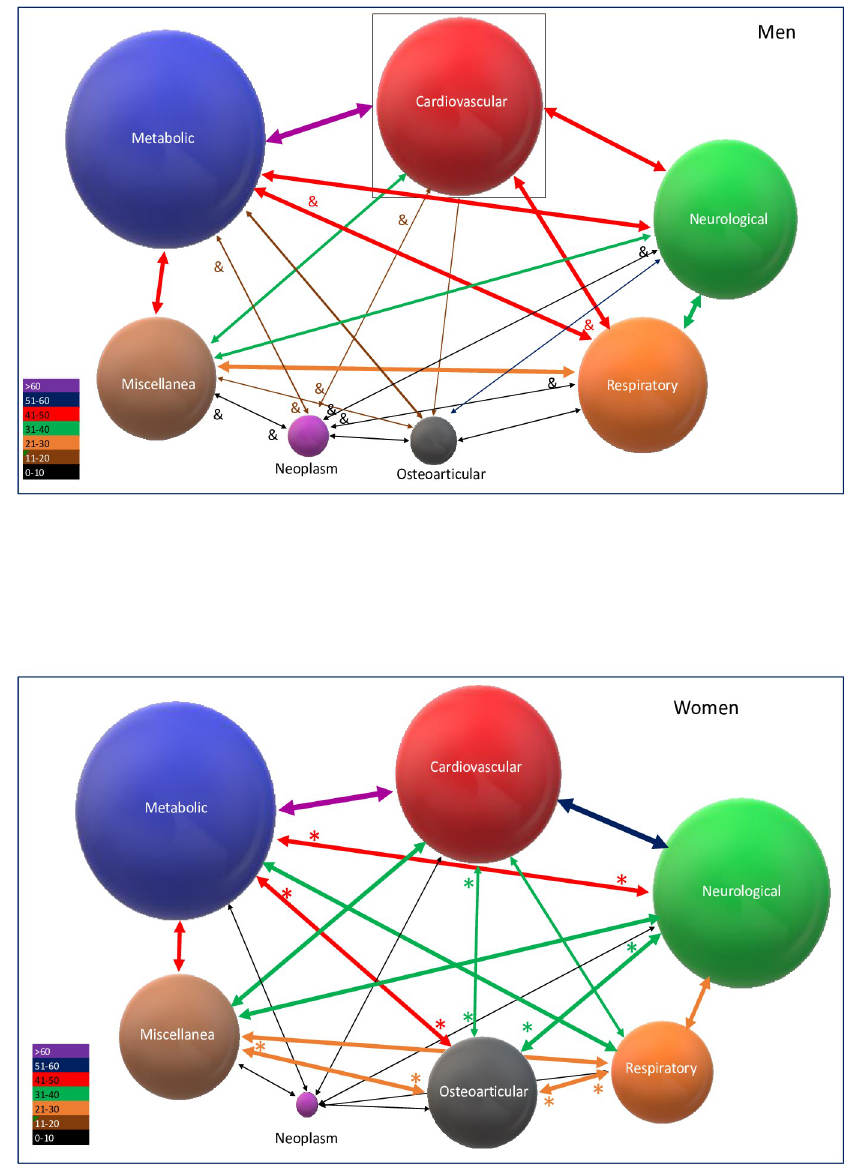
Fig 2. The diameter of the spheres represents the prevalence in pattern percentage, while union lines express the frequency of the relationship. Violet lines > 60%, Blue lines 51–60%, Red lines 41–50%, Green lines 31–40%%, Orange lines 21–30, Brown lines 11–20%, Black lines < 11%. � The association between patterns is statistically significantly higher in men than in women. & The association between patterns is statistically significantly higher in women than in